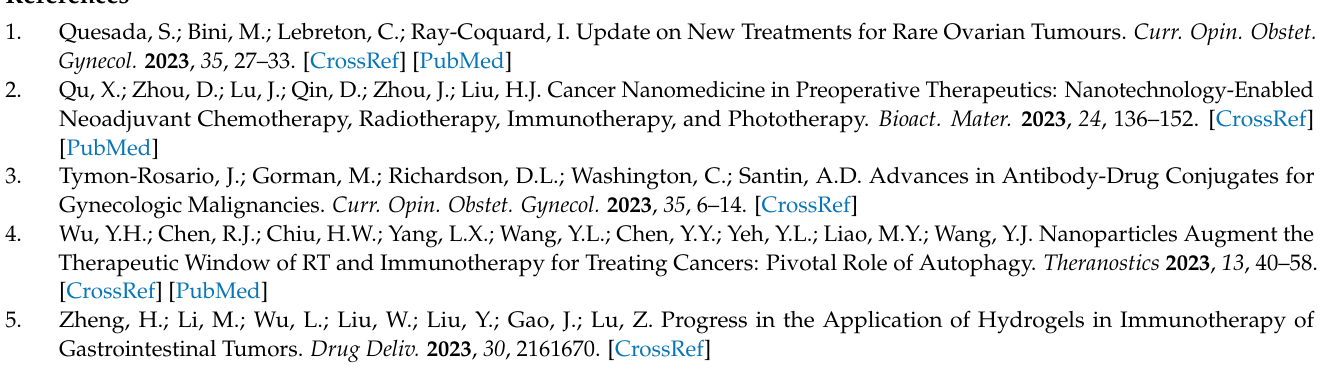
Table S8. Estimated binding free energy, visualization of binding pose and predicted interactions with αβ -tubulin heterodimer for compounds ( 1a , 1c , 1d , 1i , 2i , 2j , 3h